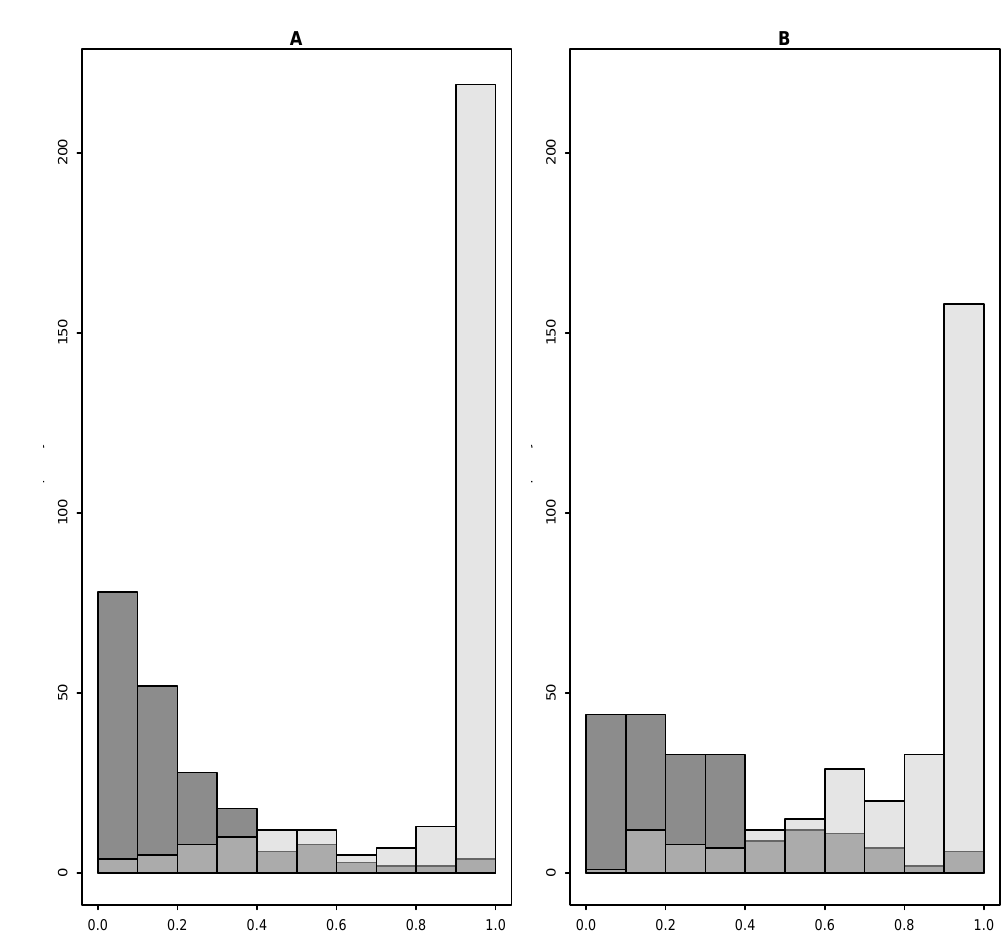
Figure 1. Propensity score distributions between the treated (grey) and control (black) if ( A ) including = 18% and π 0.95 = 22%; ( B ) if including only the all covariates in the propensity score model, π 0.95 z = 0 z = 1 covariates that were selected more than 20% of times by Step_ALT among 1000 bootstrap samples, = 33% and π 0.95 = π 0.95 z = 0 z = 1